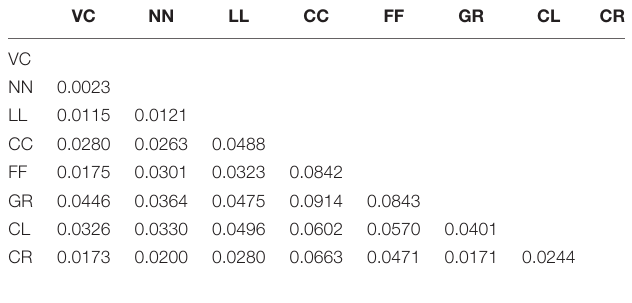
TABLE 7 | Pairwise F ST estimates between the eight chicken phenotypes based on the 20 microsatellite loci.